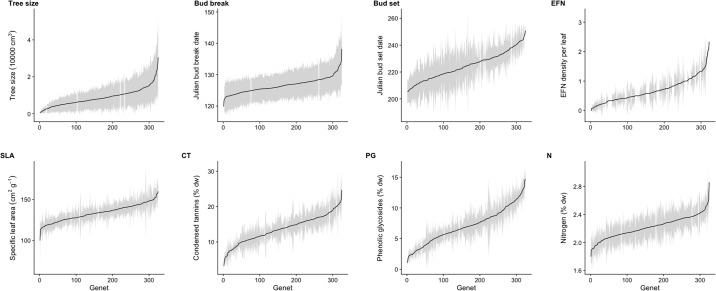
Bar plots of tree trait variation.Variation in tree traits (tree size, Julian bud break date, Julian bud set date, density of extra-floral nectaries per leaf [EFN], specific leaf area [SLA], levels of foliar condensed tannins [CT], levels of foliar phenolic glycosides [PG, salicortin and tremulacin combined], levels of foliar nitrogen [N]) across aspen genets at WisAsp in 2014 and 2015. Each black point is the average value across years and tree replicates, and the gray shading represents the standard deviation. All plots are ordered from low to high genet values, and the y-axes are presented with different scales.